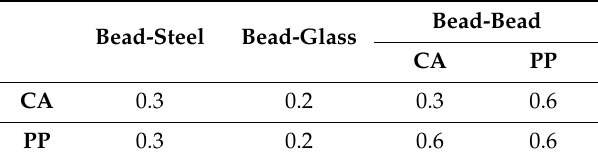
Table 3. Solid–solid static friction coe ffi